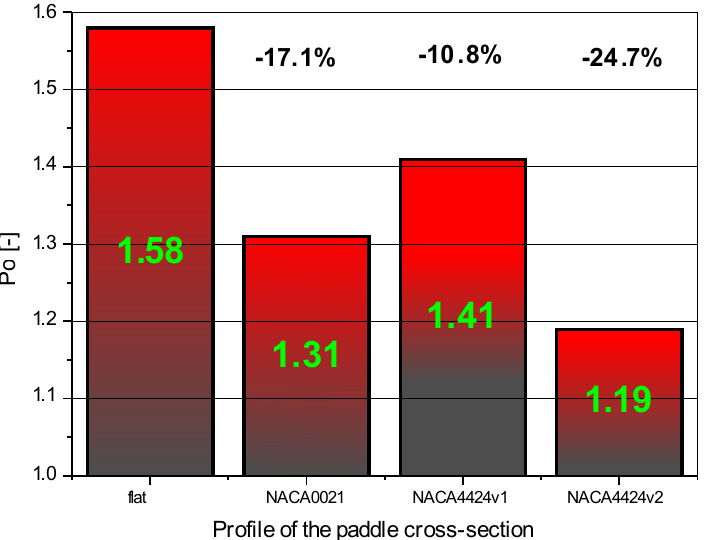
Figure 6. Mixing power numbers of the tested impeller designs.